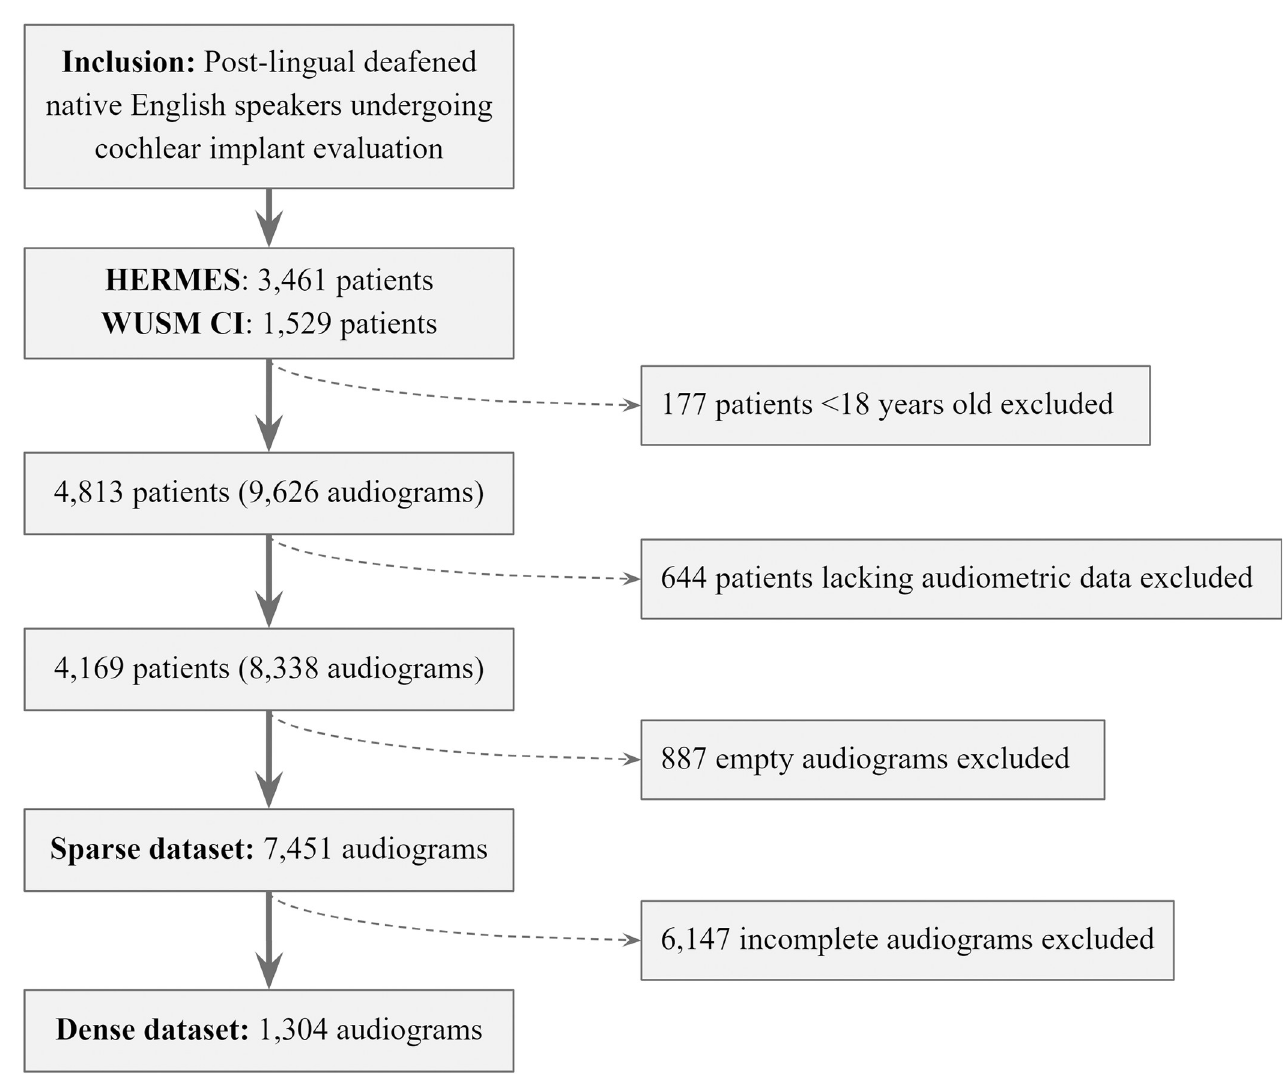
Fig 1. Dataset creation. Flow chart for inclusion and exclusion of subjects and audiograms. Data drawn from the Washington University School of Medicine in St. Louis Cochlear Implant database (WUSM CI) and the HIPPA-secure, Encrypted, Research, Management, and Evaluation Solution database (HERMES).